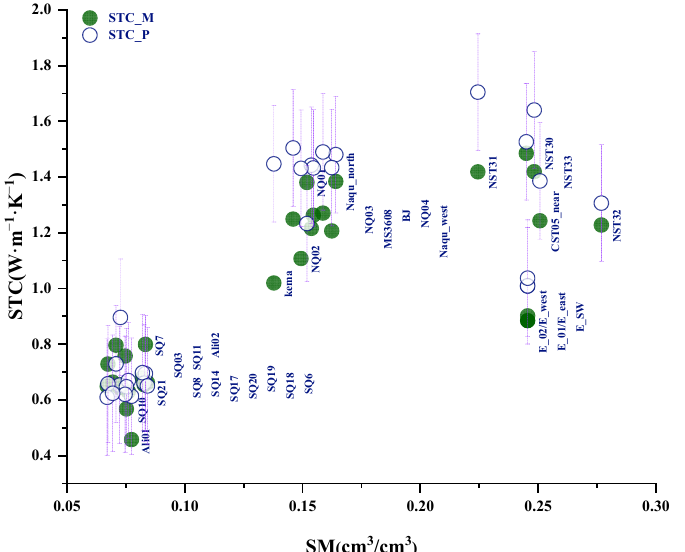
Figure 7. Relationship between measured (STC_M) and simulated (STC_P) values of STC under different soil moisture conditions.